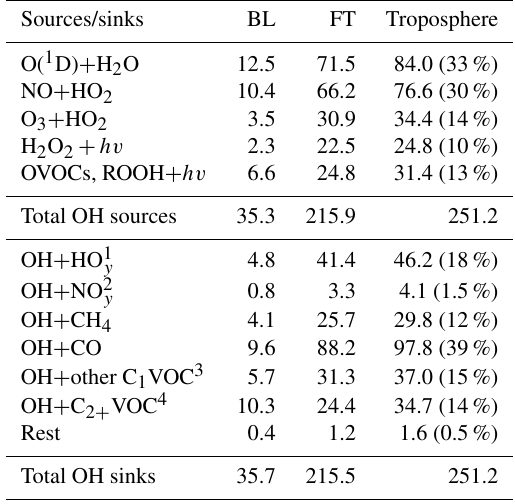
Table 1. Global, annual mean tropospheric source and sink fluxes of OH (Tmolyr − 1 ). Sources and sinks are also specified for the boundary layer and free